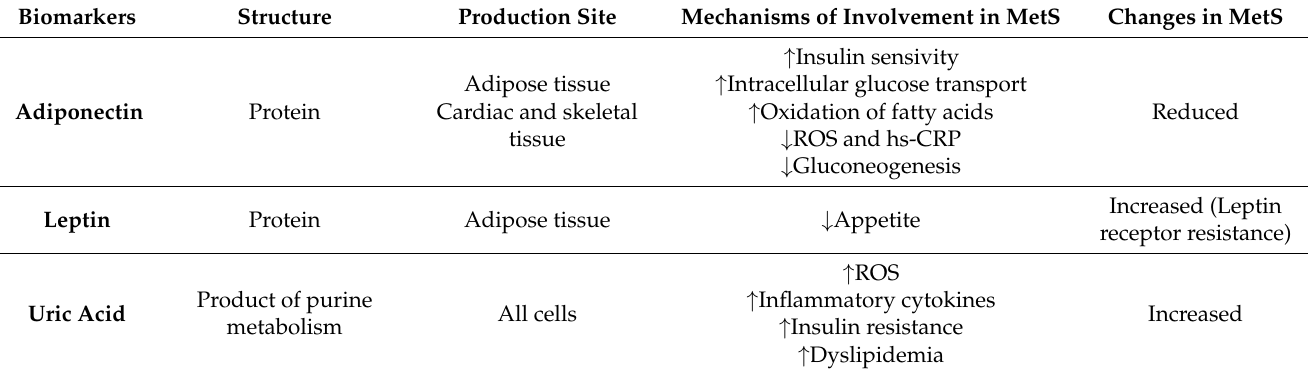
Figure 2. Mechanisms of action of the biomarkers of MetS. Radiotherapy, chemotherapy and high dose steroids cause the appearance of weight gain with a consequent increase in the hepatic pro- duction of apoB, Lp(a) and hs-CRP, a reduction in the production of adiponectin by the adipose tissue and a simultaneous reduction in the production of leptin, reduction in the production of IL-1, IL-6, TNF by the immune and non-immune cells, and uric acid. The production of these markers determines insulin resistance, inflammation, dyslipidemia, production of reactive oxygen species (ROS), and atherosclerosis. Table 1. Biomarkers predictive of MetS. The table summarizes the structural characteristics, produc- tion sites and mechanisms of action of the biomarkers examined.